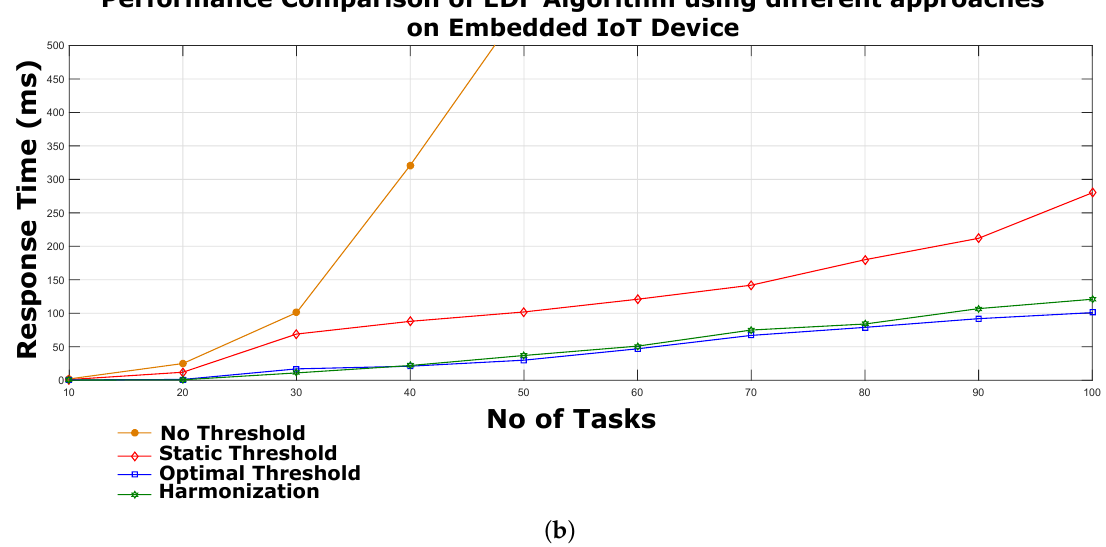
Figure 15. Performance Comparison of RM and EDF algorithms on Raspberry Pi-based Embedded IoT Device using various approaches. ( a ) performance of RM algorithm—Existing Approaches vs. Proposed Approach; ( b ) performance of EDF algorithm—Existing Approaches vs. Proposed